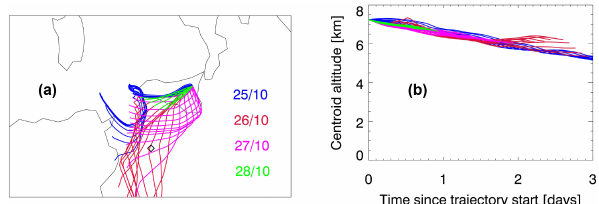
Figure 3. (a) Bi-hourly forward trajectories of the volcanic plume, taken as the centroid of the sulfur dioxide plume, for the period 25–28 October 2013, from FLEXPART simulations. Each trajectory has temporal duration of about 3 days. Different days are identified with different colours. The position of Lampedusa is indicated with a black diamond. (b) Average altitude of the plumes for each trajec- tory identified in plot (a) , taken as the centroid of the sulfur dioxide plume, from FLEXPART